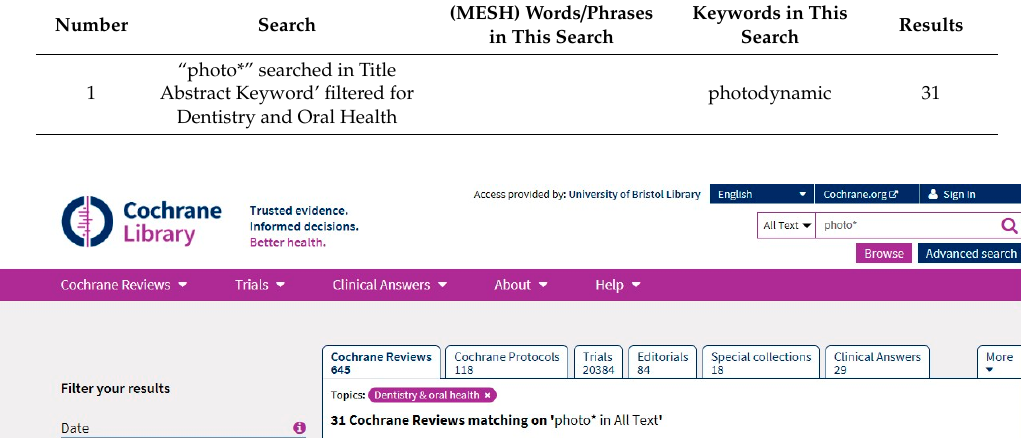
Figure A1. Cochrane review titles.